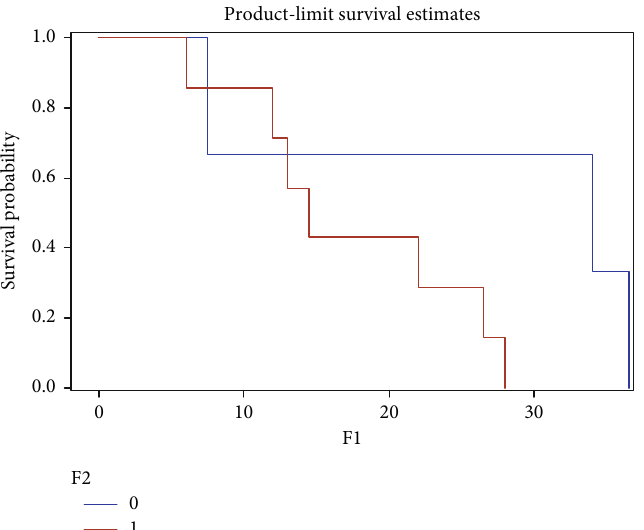
Figure 2: Kaplan-Meier survival curves for grade III gliomas. The graph shows a shorter survival in patients with the TREM-1/TREM-2 ratio > 125 ( P = 0 : 012 ) (test used: Log Rank; x -axis: survival time in months; y -axis: survival probability; 0: patients with TREM-1/TREM- 2 ratio < 125 ( n = 4 ); 1: patients with TREM-1/TREM-2 ratio > 125 ( n = 6 )).